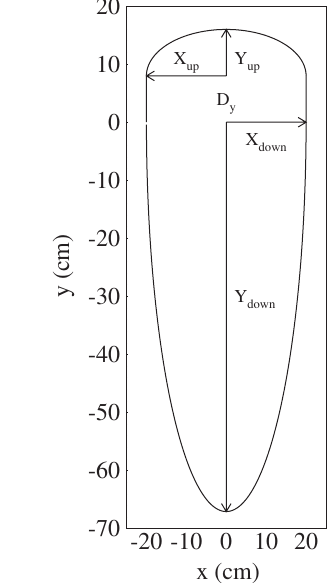
and Y ) are down up . y